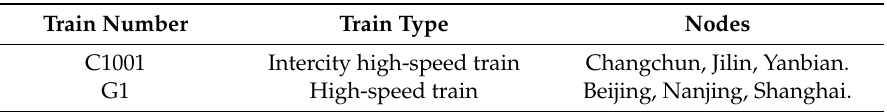
Table 1. Sample train lines data for two kinds of train